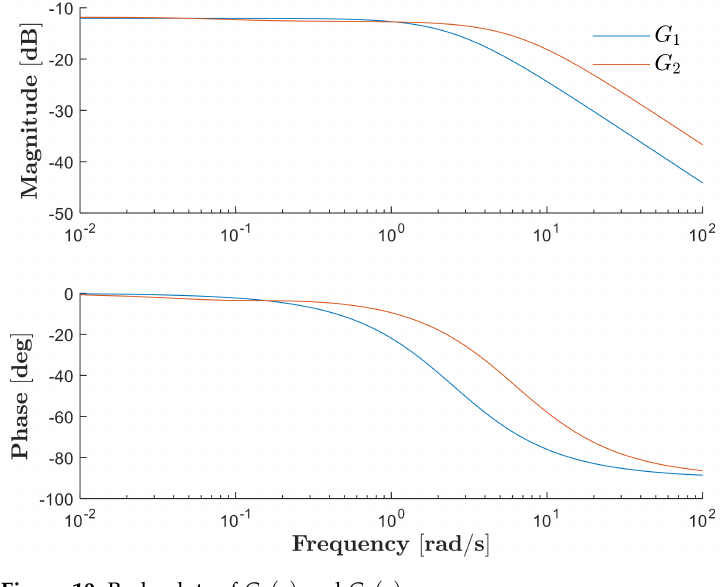
Figure 10. Bode plots of G 1 ( s ) and G 2 ( s ) .